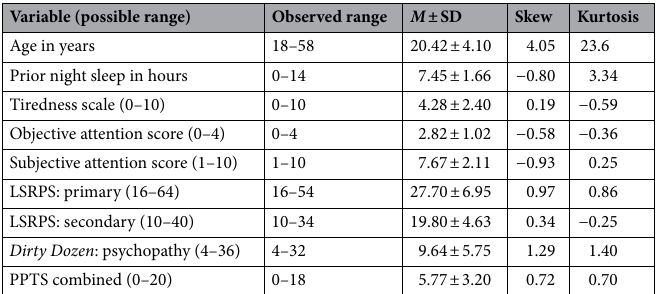
Table 1. Descriptive statistics. Note: Internal consistency was acceptable for all measures of psychopathy: LSRPS: primary (α = 0.808); LSRPS: secondary (α = 0.671); Dirty Dozen : psychopathy (α = 0.770); PPTS combined (α = 0.710).